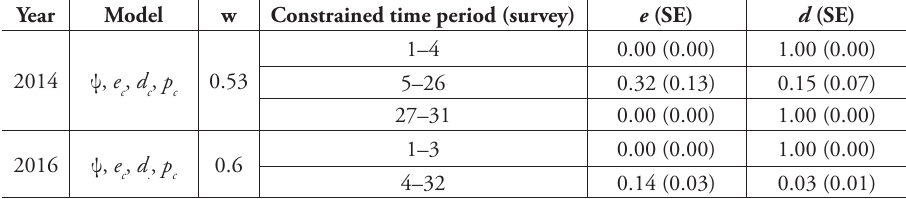
Table 5. Cerambyx cerdo entry ( e ) and departure ( d ) probability estimates and associated standard errors (SE) are given for the top models. w is the Akaike’s weight for each model. Detection/non-detection data were recorded during surveys carried out in 2014 and 2016.